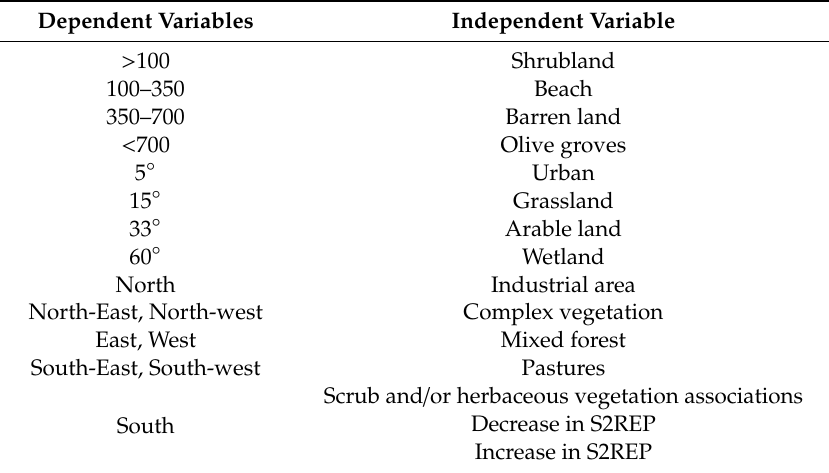
Table 4. Dependent and independent variables enclosed within the study